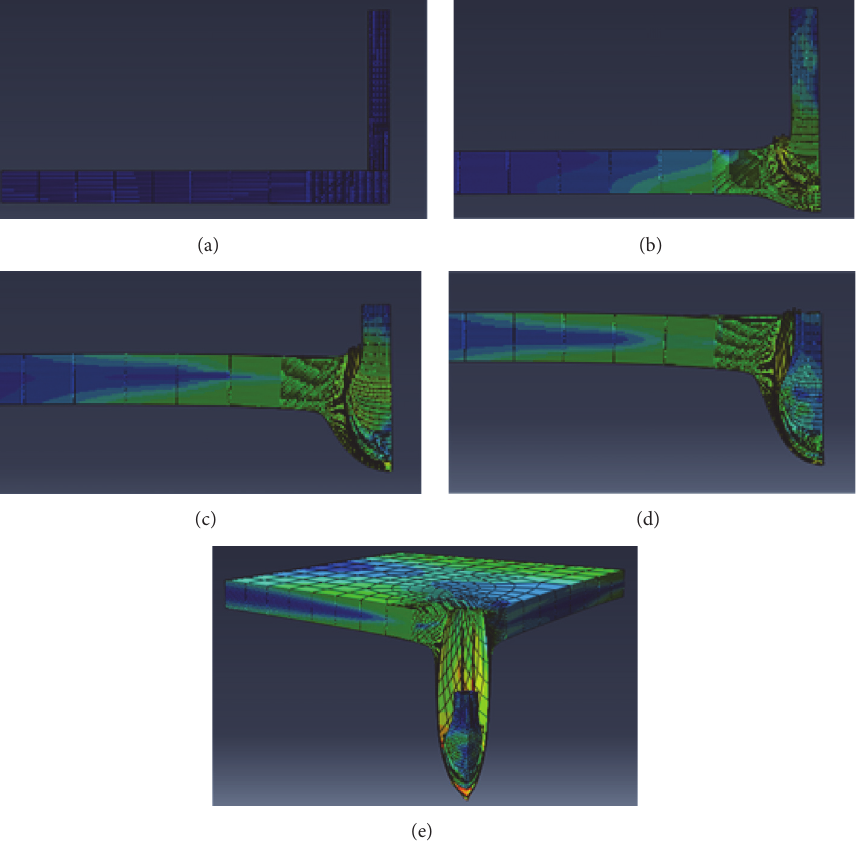
Figure 5: Penetration simulation yielded from the ISV damage model, V initial = 200 m/s at 𝑡 = 0 (a), 50 𝜇 s (b), 100 𝜇 s (c), 150 𝜇 s (d), and 265 𝜇 s (e).